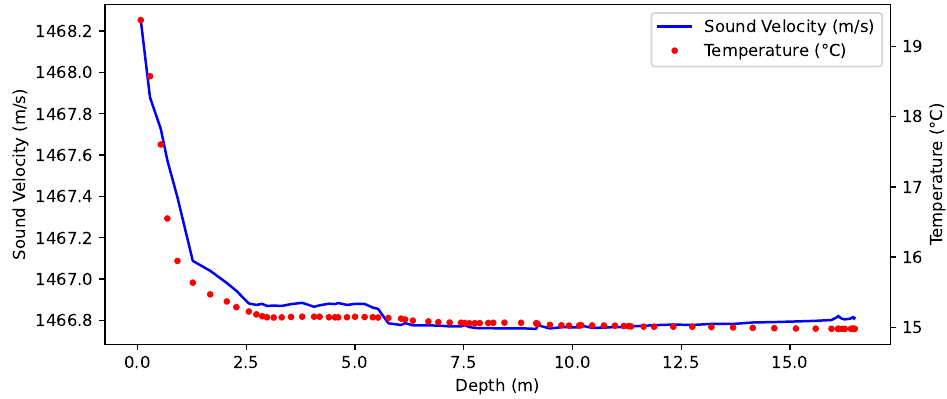
Figure 8. Course of the sound profile and the water parameters during the echo sounder